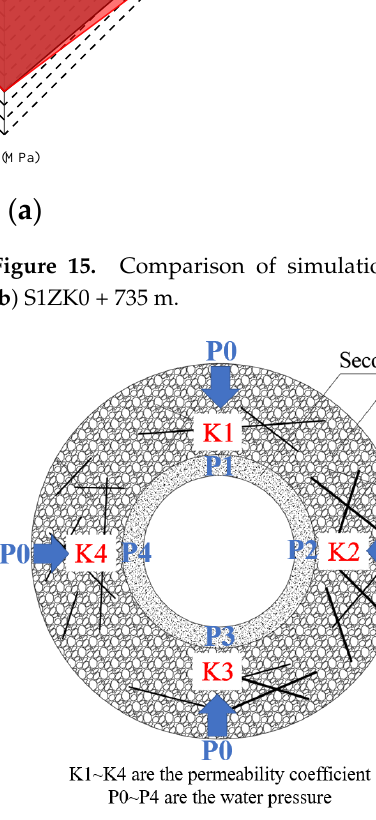
Figure 15. Comparison of simulation results with monitoring results. ( a ) S1ZK0 + 660 m; ( b ) S1ZK0 + 735 m.